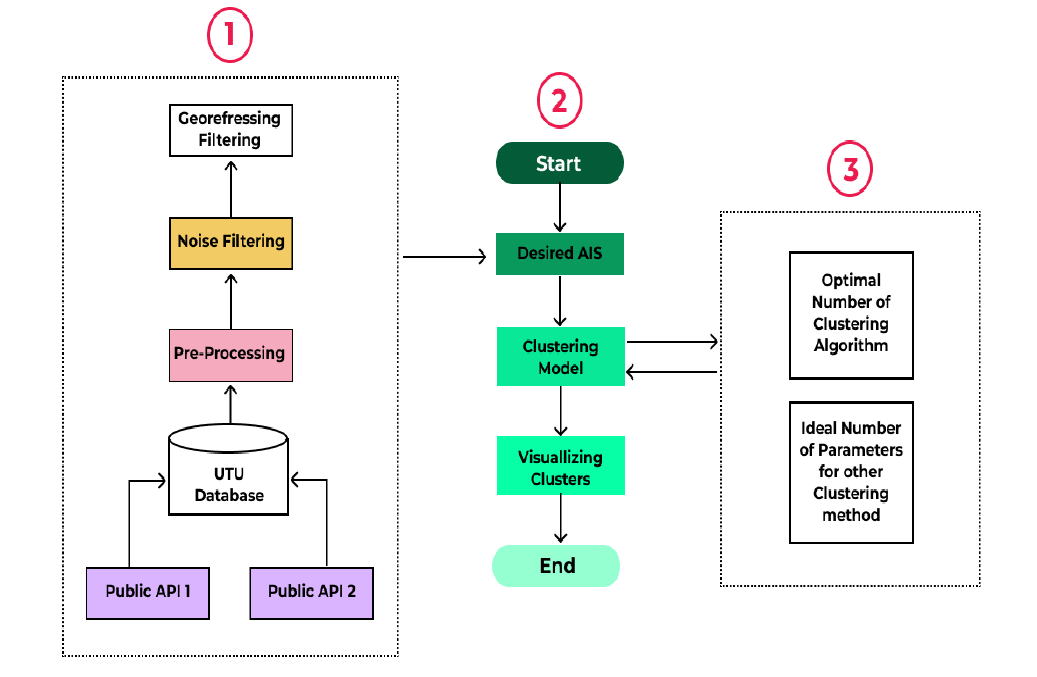
Figure 6. The proposed framework for abnormal detection in marine